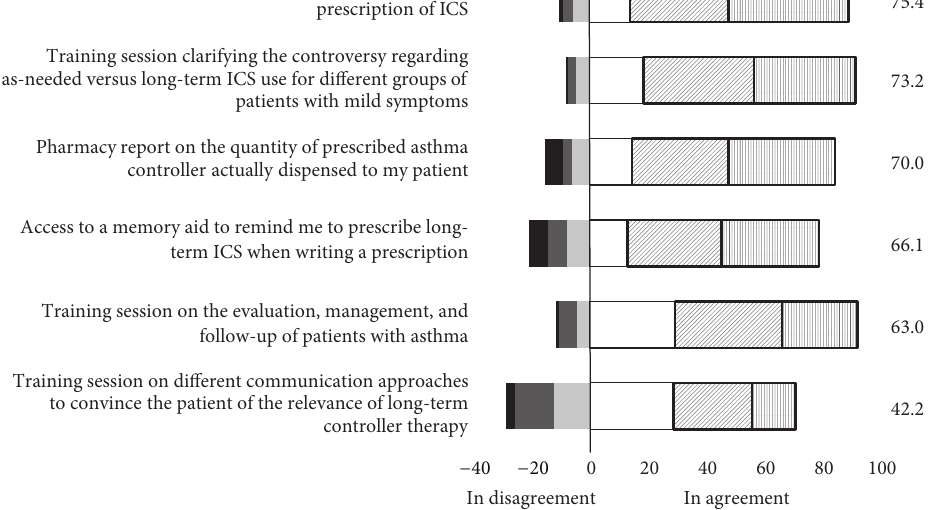
Figure 2: This histogram depicts the physicians’ endorsement, adjusted for the sampling fraction, of each proposed enablers on a Likert-like scale ranging between 5 indicating strong agreement (vertical bars), 4 (diagonal grey bars), 3 (white), 2 (light grey), 1 (medium grey), and 0 indicating strong disagreement (black). The proportion of participants with strong endorsement, that is, answering 4 or 5, is identified by a dark box in the histogram and displayed in the right